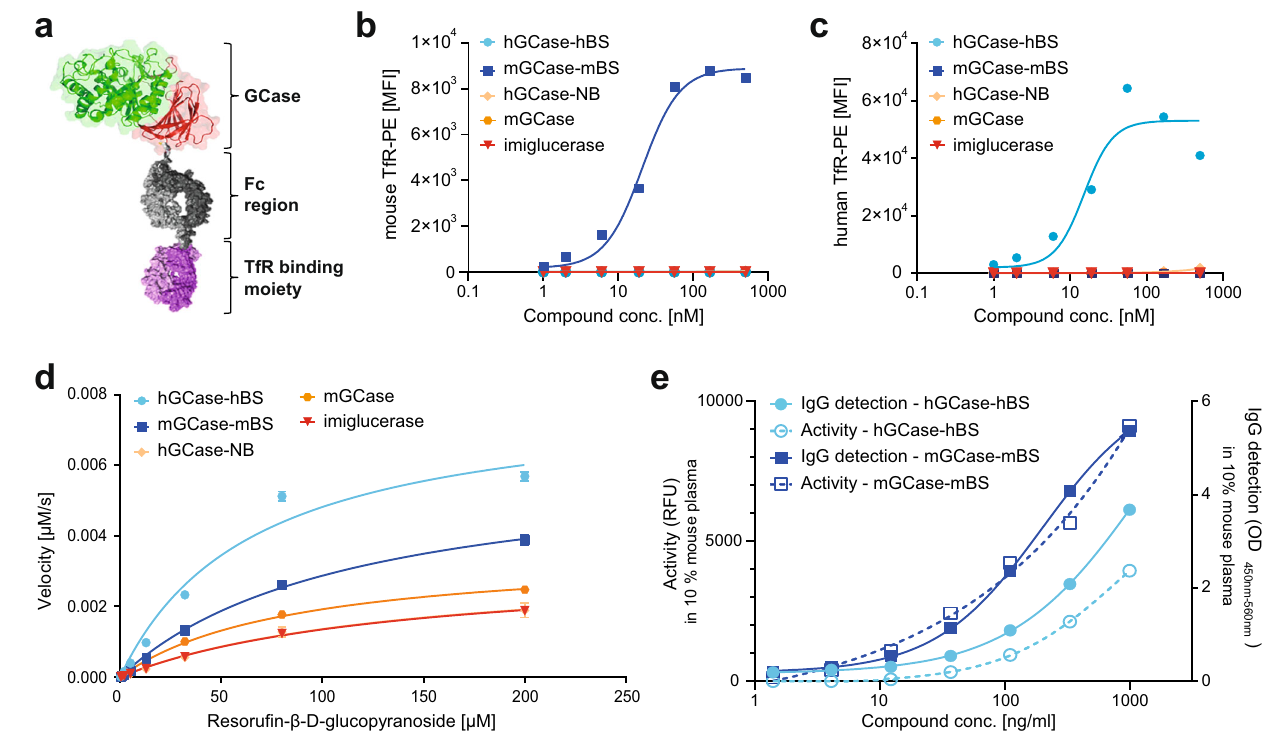
Fig.1|Puri fi edGCase-BSmoleculesarefullyfunctional.a SchematicofGCase-BS depicting different moieties: GCase domain II is shown in red, domain III in green, domain I is hidden behind domain III in this view 23 . The human IgG1 Fc part of the Brain Shuttle is shown in grey, the TfR binding Fab is depicted in purple. b Assessment and speci fi city of murine TfR binding of the various GCase(-BS) molecules by FACS analysis of mTfR-expressing cells. Representative data of 2 biological replicates. c Assessment and speci fi city of human TfR binding of the various GCase(-BS) molecules by FACS analysis of hTfR-expressing